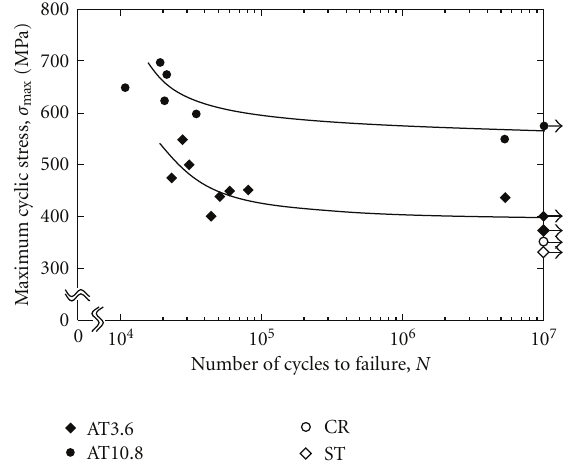
Figure 7: Fatigue properties of AT3.6, AT10.8 ST, and CR samples.